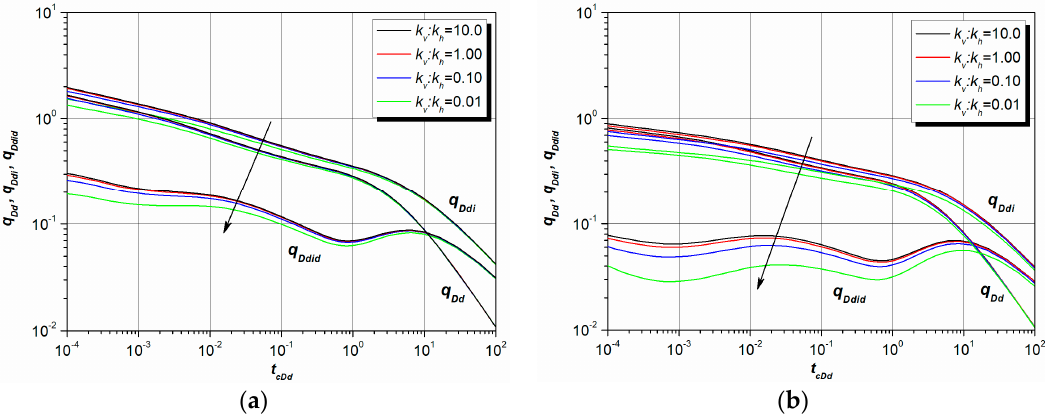
Figure 10. The effect of Ratio of vertical permeability to horizontal permeability on combined type curves of an MFHW: ( a ) h = 20 m; ( b ) h = 100 m.